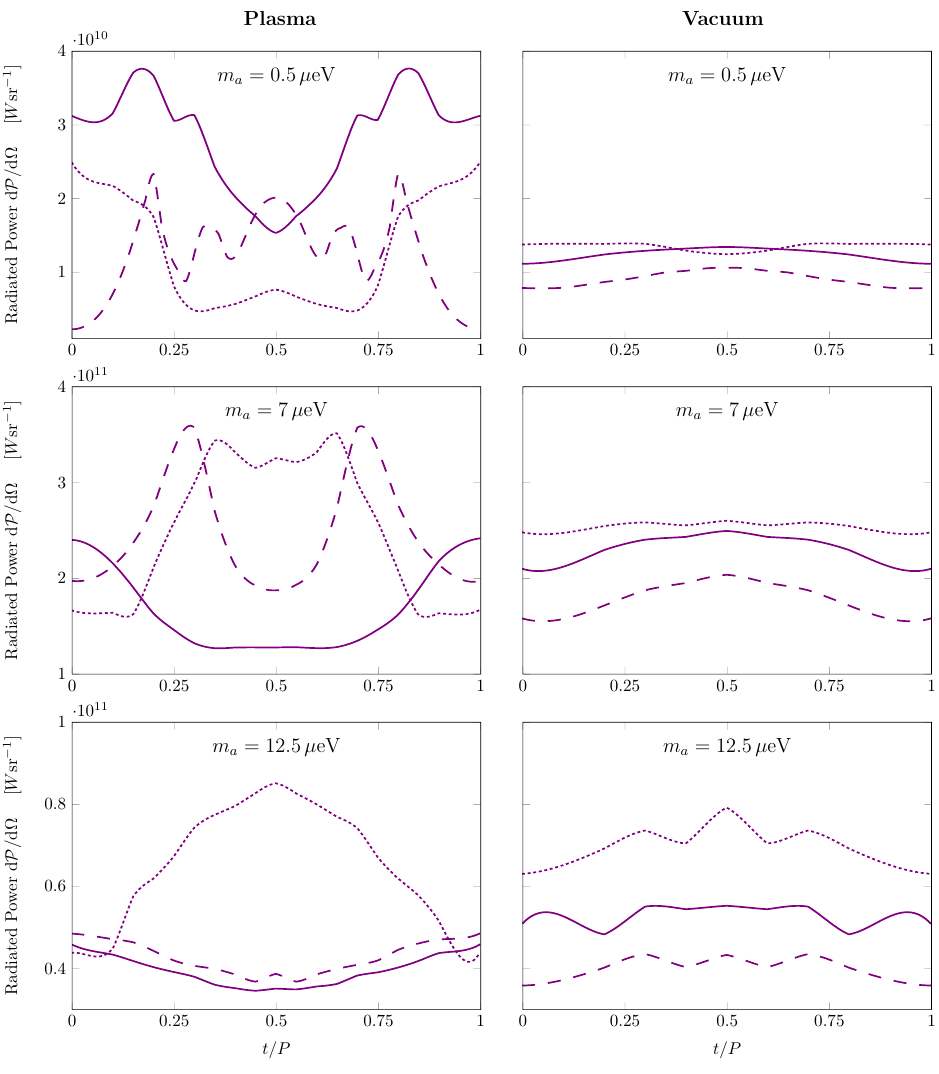
Figure 3 . Pulse profiles. A comparison of pulse profiles with and without plasma is shown in the left and right columns, respectively. The plasma case is computed via eq. (3.4). Plots show the radiated power over all frequencies. From top to bottom we show the results for axion masses m a = 0 . 5 , 7 , 12 . 5 µ eV. The dashed, solid and dotted lines correspond to an observing polar angle of θ = 36 ◦ , 54 ◦ and 72 ◦ , respectively. Other model parameters are chosen as in figure